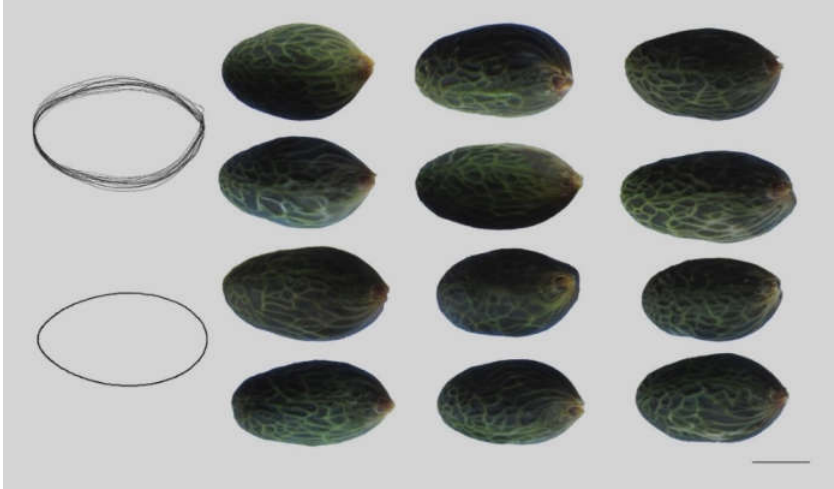
Figure 10. Seed shape quantification by an oval in Chamaedorea pauciflora . Left, above: Image with superimposed silhouettes of 12 seeds. Left, below: The model, an oval defined by the equation given in the text. The seed images used for seed shape quantification (comparison with the model) are in three columns and four rows. J index value (mean of 12 measurements) is 90.7. Bar represents 0.5 cm.